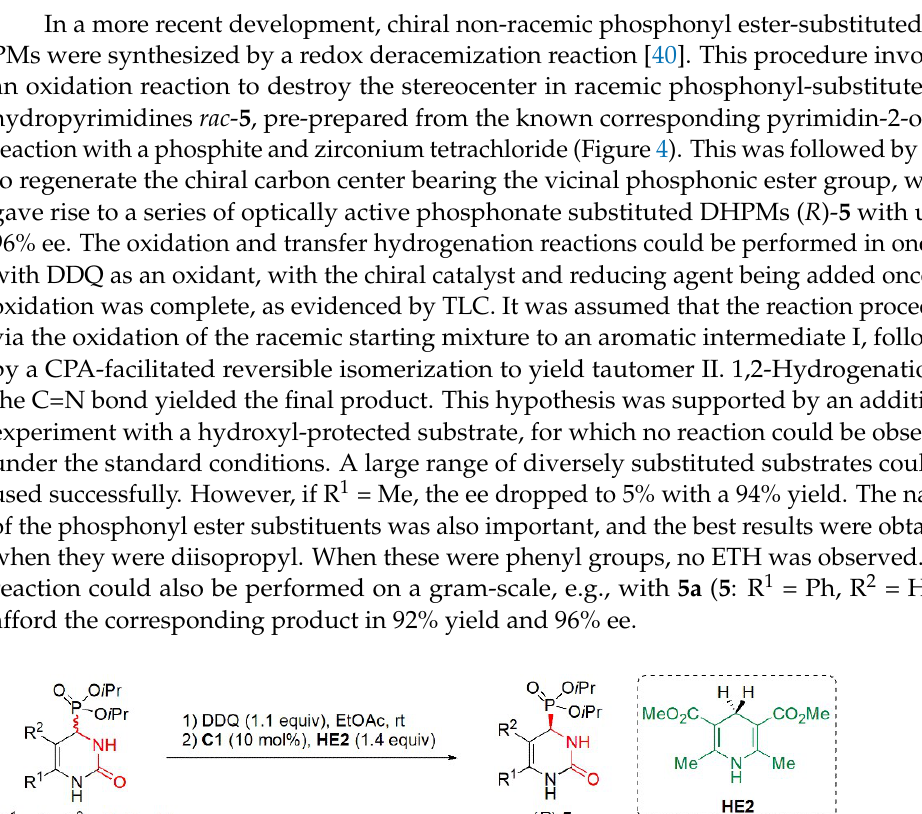
Figure 3. Enantioselective 1,4-reduction of pyrimidin-2-ones to 3,4-dihydropyrimidin-2(1 H )-ones [39].